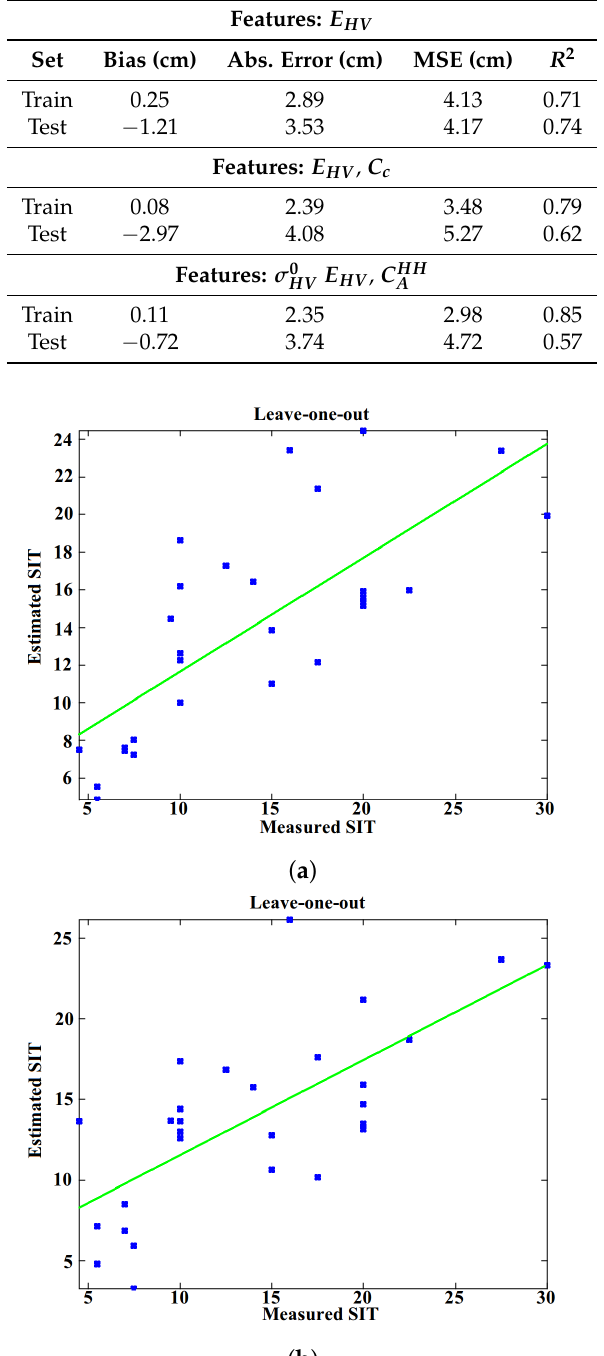
Figure 16. The results for the sea ice thickness estimation leave-one-out experiment with ( a ) one feature and ( b ) three features. RMSE = 4.5 cm (one feature) and RMSE = 6.0 cm (three